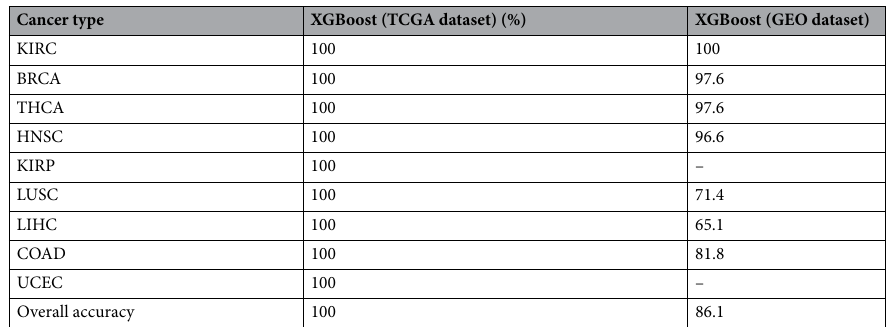
Table 2. Classification accuracy of XGBoost on TCGA and GEO datasets. KIRC kidney renal clear cell carcinoma, BRCA breast invasive carcinoma, THCA thyroid carcinoma, HNSC head and neck